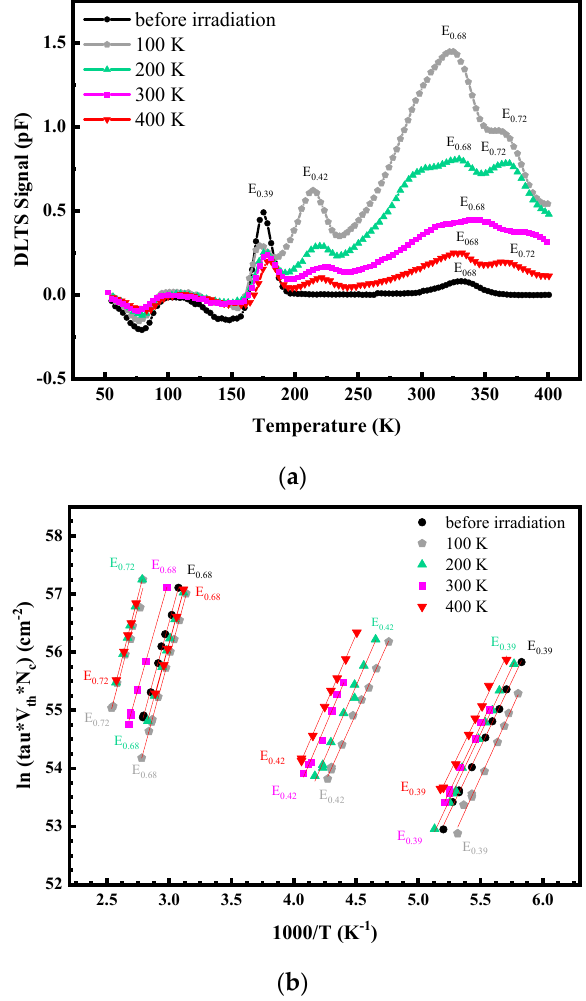
Figure 7. ( a ) DLTS spectra for the unirradiated and irradiated SiC Schottky barrier diode dies after 2 MeV proton irradiation. ( b ) Arrhenius plots of the defects obtained from DLTS spectra.